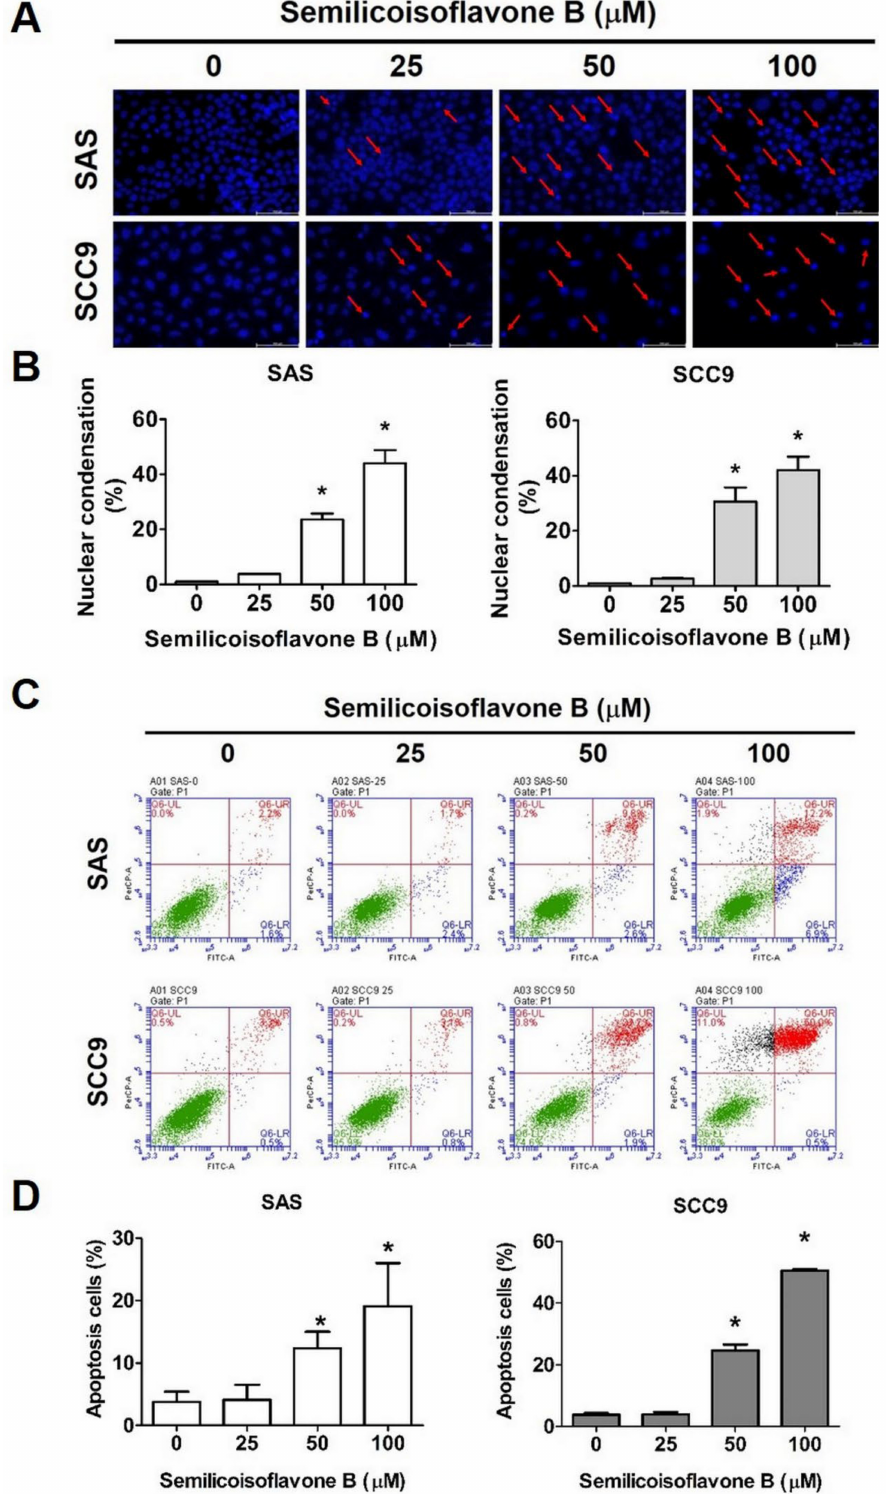
Figure 3. Semilicoisoflavone B induces apoptosis in SAS and SCC9 cells. After treated SFB (0–100 µ M) for 24 h. ( A ) Used DAPI stain assay to determine DNA condensation with fluorescence microscopy. ( B ) Quantitative relative density of the percentage of nuclear condensation. ( C ) Cells were stained with Annexin V/PI and flow cytometry was used to reveal SFB-induced apoptosis. ( D ) Quantitative relative density of the percentage of apoptosis cells (including early and late state). Data are presented as mean ± SD ( n = 3). * p < 0.05, compared with the control